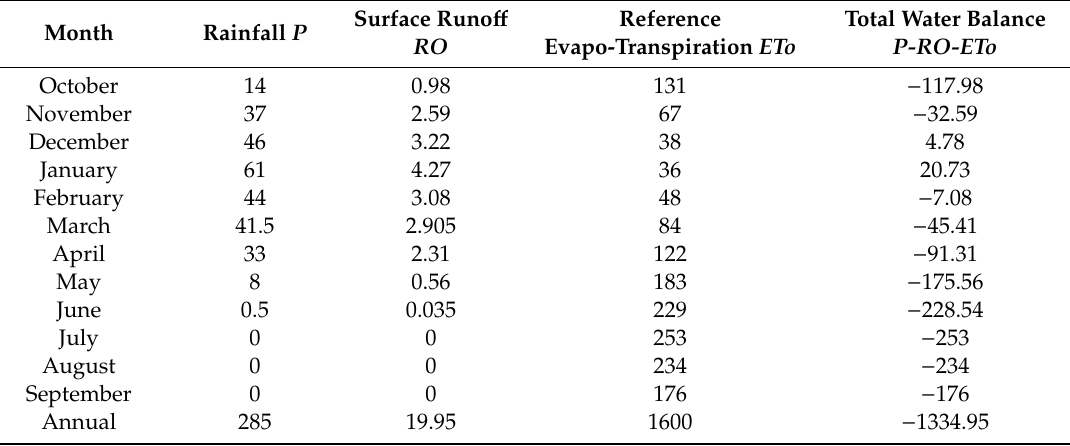
Table 1. Average monthly meteorological data (mm) 1981–2010 within the central part of Diayal river basin